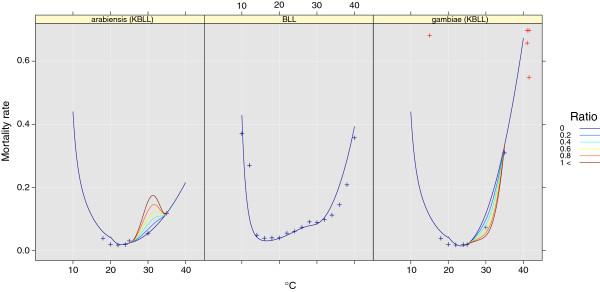
Water temperature and mortality rates (day-1) in the aquatic compartments. Blue points show data used to estimate the mortality curves. Blue lines indicate mortality without competition, while light blue to red shows mortality as competition increases. For reference, red points show data from Holstein [98].